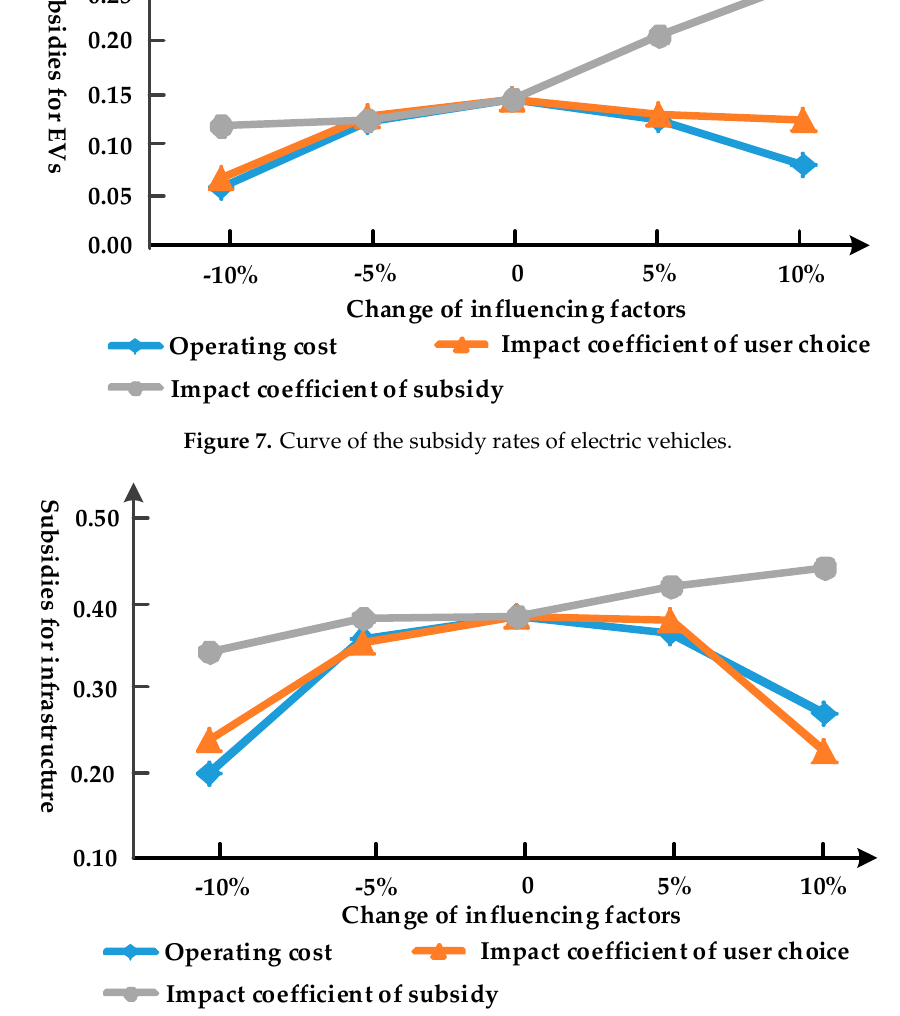
Figure 8. Curve of subsidy rates of infrastructure.